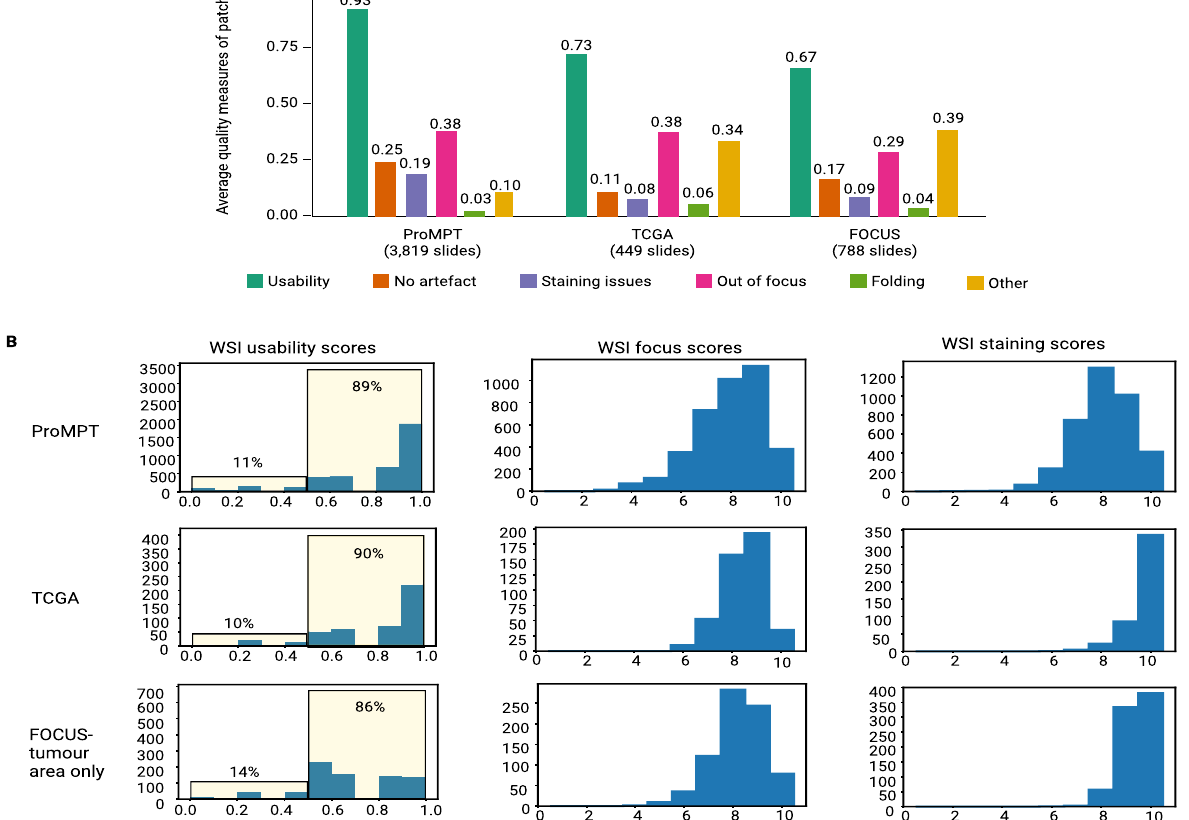
Figure 1. ( A ) Average estimated quality measures of patches extracted from the entire ProMPT cohort (3819 WSIs), and the TCGA-prostate (449 WSIs), and FOCUS (788 WSIs) cohorts. ( B ) Distribution of estimated usability scores of WSIs in each cohort (entire ProMPT cohort, TCGA, and FOCUS) and distribution of estimated scores for WSI focus and H&E staining quality (0–10, lowest quality to highest quality). WSI scores for the FOCUS cohort are calculated for tumour regions